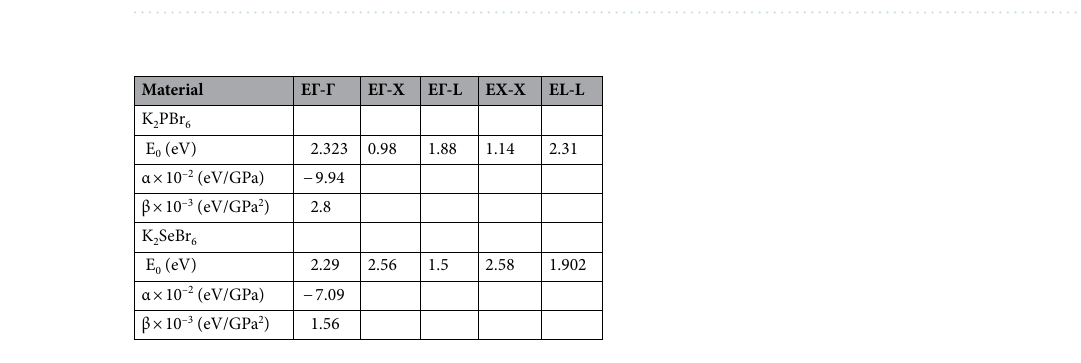
Figure 7. Band structures of K 2 XBr 6 (X = Pt, Se) in zinc blend structure performed with GGA (PBE-SOL) and HSE hybrid.